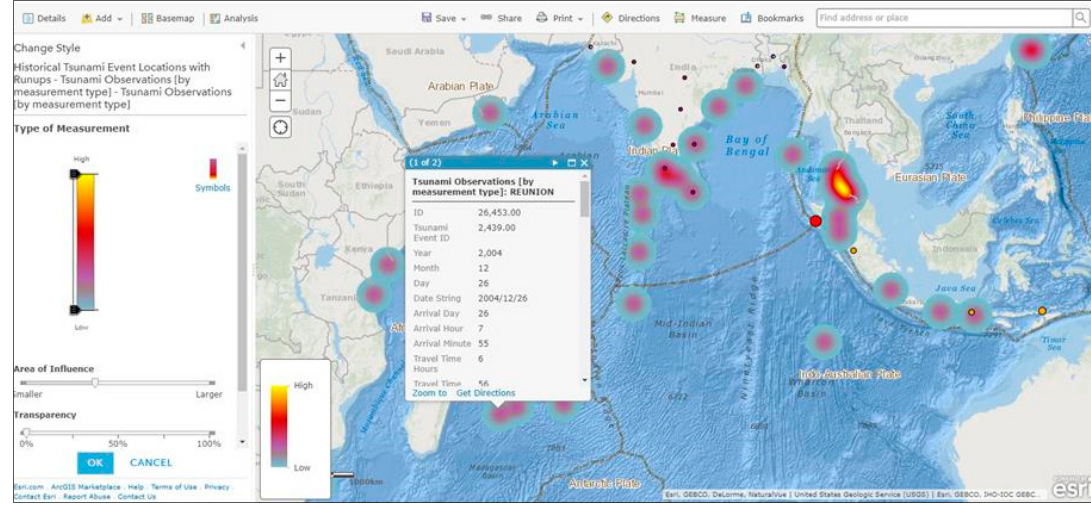
Figure 7. Exploring the shape of the ocean floor.